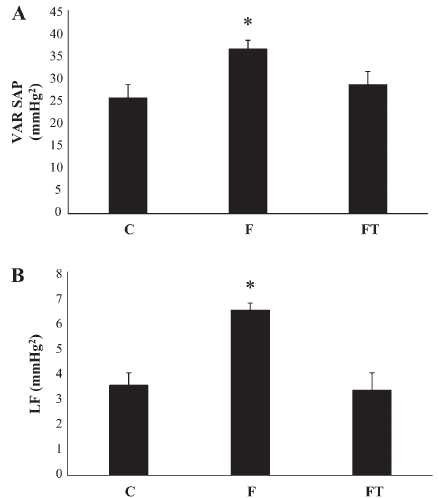
Figure 2. Variance of systolic arterial pressure (VAR SAP) and low frequency (LF) band in experimental groups. Data are reported as means±SE. F: sedentary fructose; FT: trained fructose. *P , 0.05 vs sedentary control (C) (one-way ANOVA followed by Student-Newman-Keuls